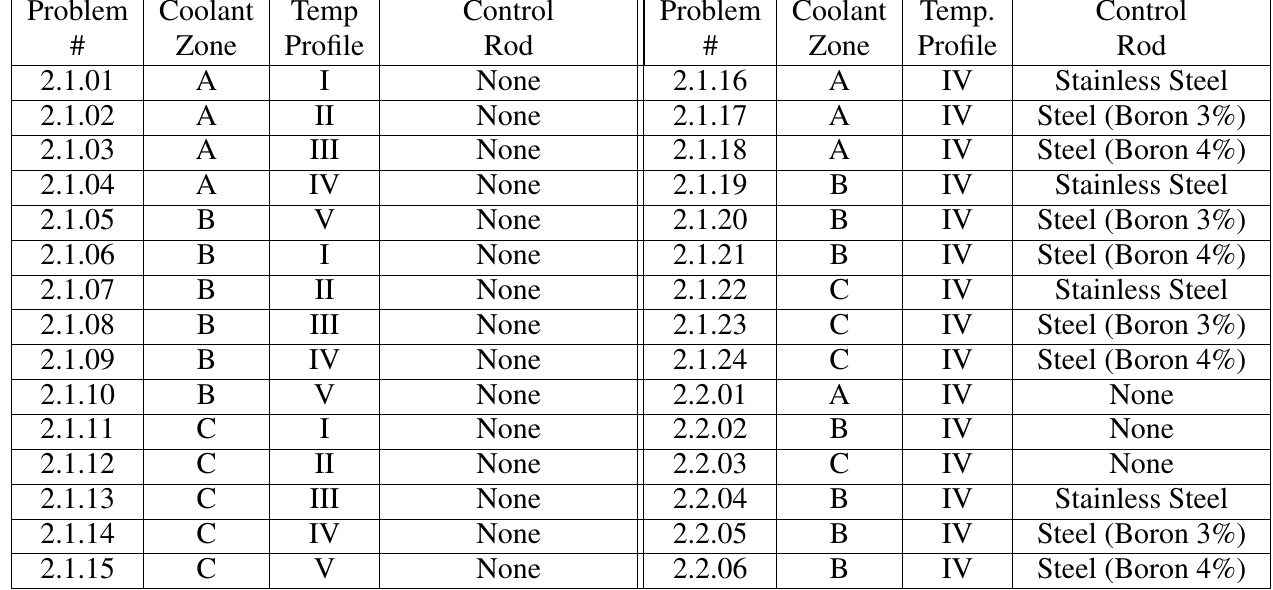
Table 3: Natural Uranium Charge Pan BOC Problems